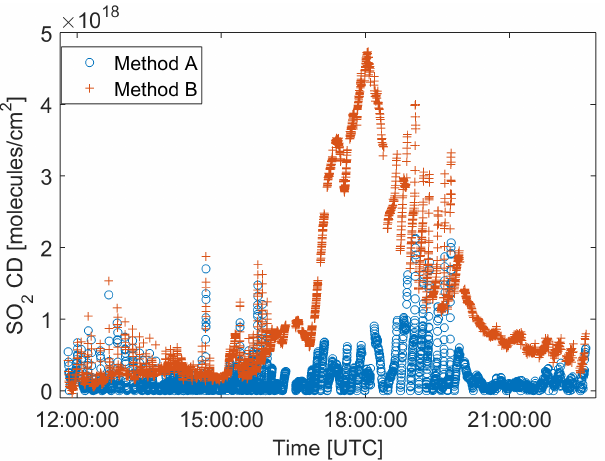
Figure 7. SO 2 CDs at Nevado del Ruiz on 6 March 2012 from in- strument D2J2201. Method A (which is similar to the standard NO- VAC approach) leads to much lower SO 2 CDs compared to Method B (modelled FRS). Many of the scans from this day would have been rejected by the standard NOVAC evaluation due to very low plume completeness values (see Galle et al., 2010, for details on plume